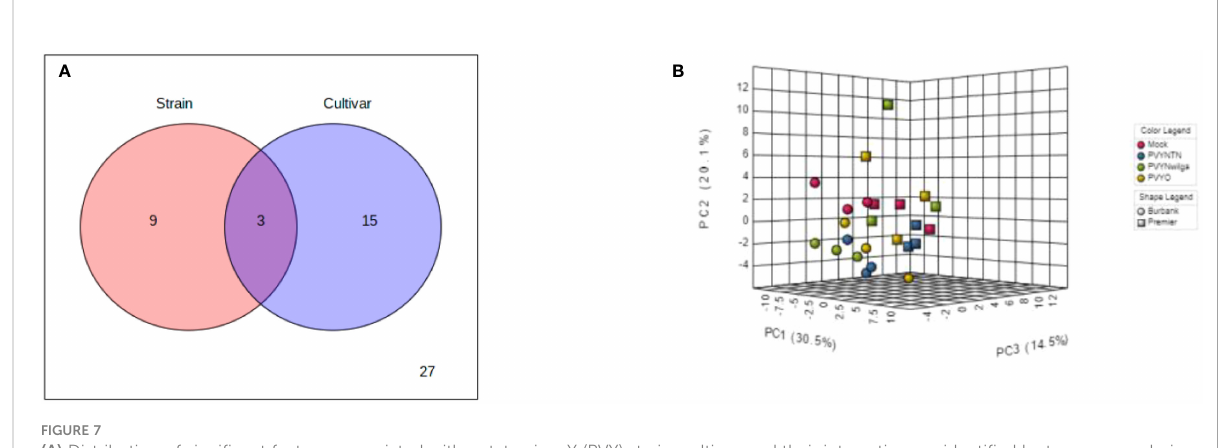
FIGURE 7 (A) Distribution of signi fi cant features associated with potato virus Y (PVY) strain, cultivar, and their interactions as identi fi ed by two-way analysis of variance (ANOVA). The default FDR (False Discovery Rate) and adjusted p -value of 0.05 were used. (B) Integrated Principal Components Analysis (iPCA) of PVY strain and cultivar. iPCA score plot indicates signi fi cant clustering and general grouping by strain and